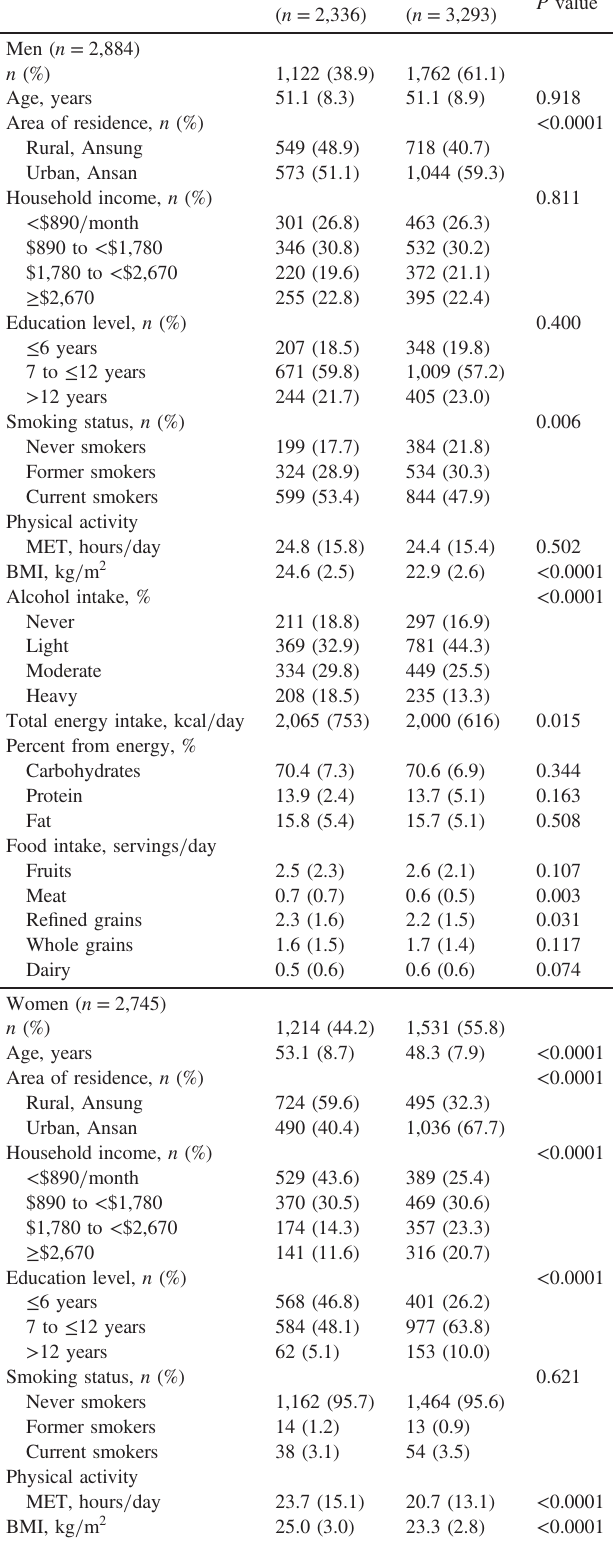
Table 1. Baseline characteristics of Korean adults according to development of metabolic syndrome